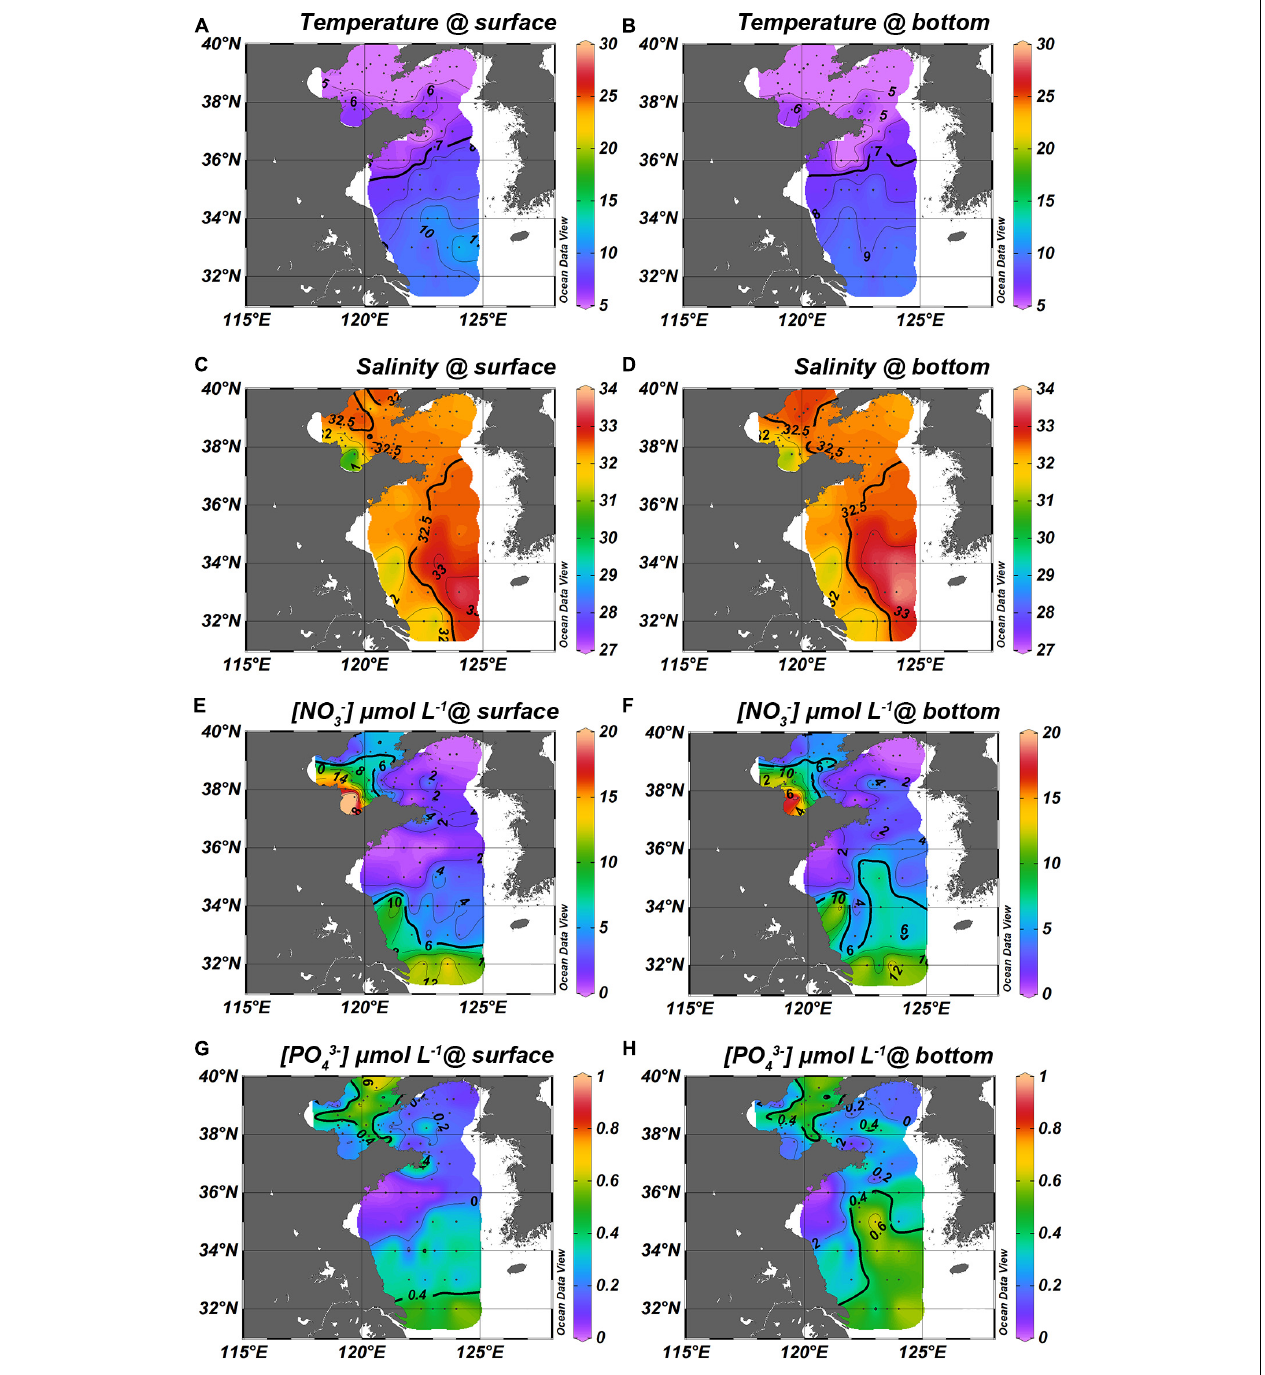
FIGURE 2 | Patterns of temperature, salinity, nitrate and phosphate in spring. The left column (A,C,E,G) are surface layers while the right column (B,D,F,H) is the bottom layers [data of the Bohai Sea shown in this figure were sampled in the same campaigns with the Yellow Sea, more details are in Tian et al. (2020),